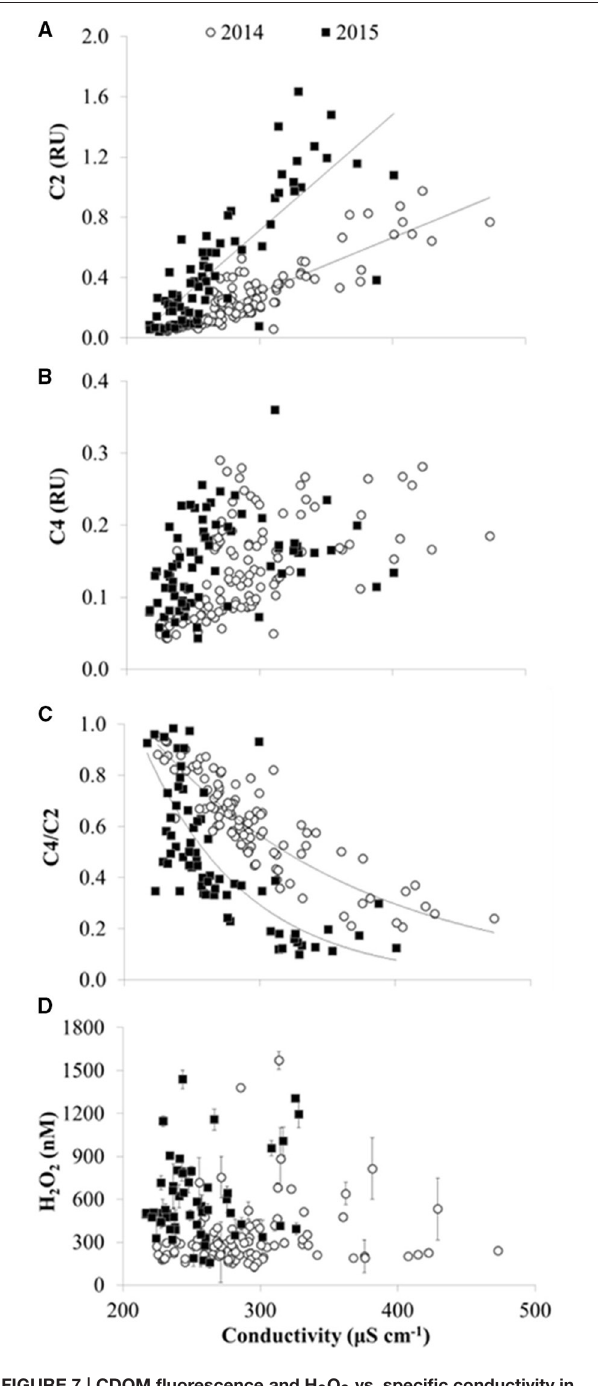
FIGURE 7 | CDOM fluorescence and H 2 O 2 vs. specific conductivity in 2014 and 2015 in Lake Erie. (A) Concentration of CDOM fluorescence component C2 (terrestrial humic-like FDOM) in Raman Units (RU). Lines show fit of linear regressions for slopes significantly different than zero at p < 0.01 . (B) Concentration of CDOM component C4 (amino acid-like FDOM). While the slope of C4 vs. specific conductivity was significantly different than zero ( p < 0.05 ) for 2014 and 2015, results of the linear regression were not plotted due to R 2 < 0.3. (C) CDOM source given by the ratio of amino acid component C4 divided by terrestrial component C2 (C4/C2). Lines show exponential fit. (D) H 2 O 2 concentrations (average ± SE, n = 4